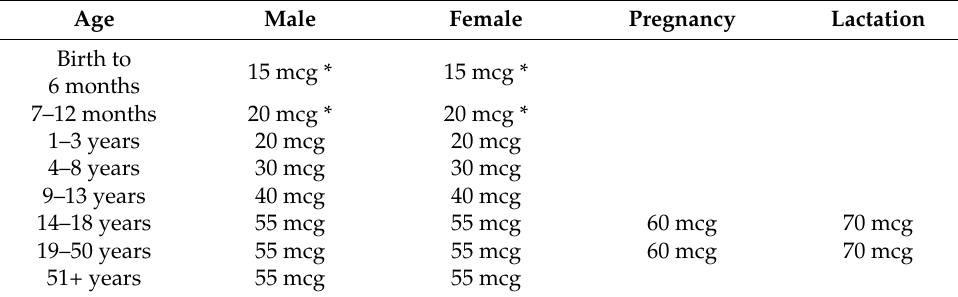
Figure 1. Recommended maximum daily dietary allowances for Se. Table 2. Recommended maximum daily Se intake levels.